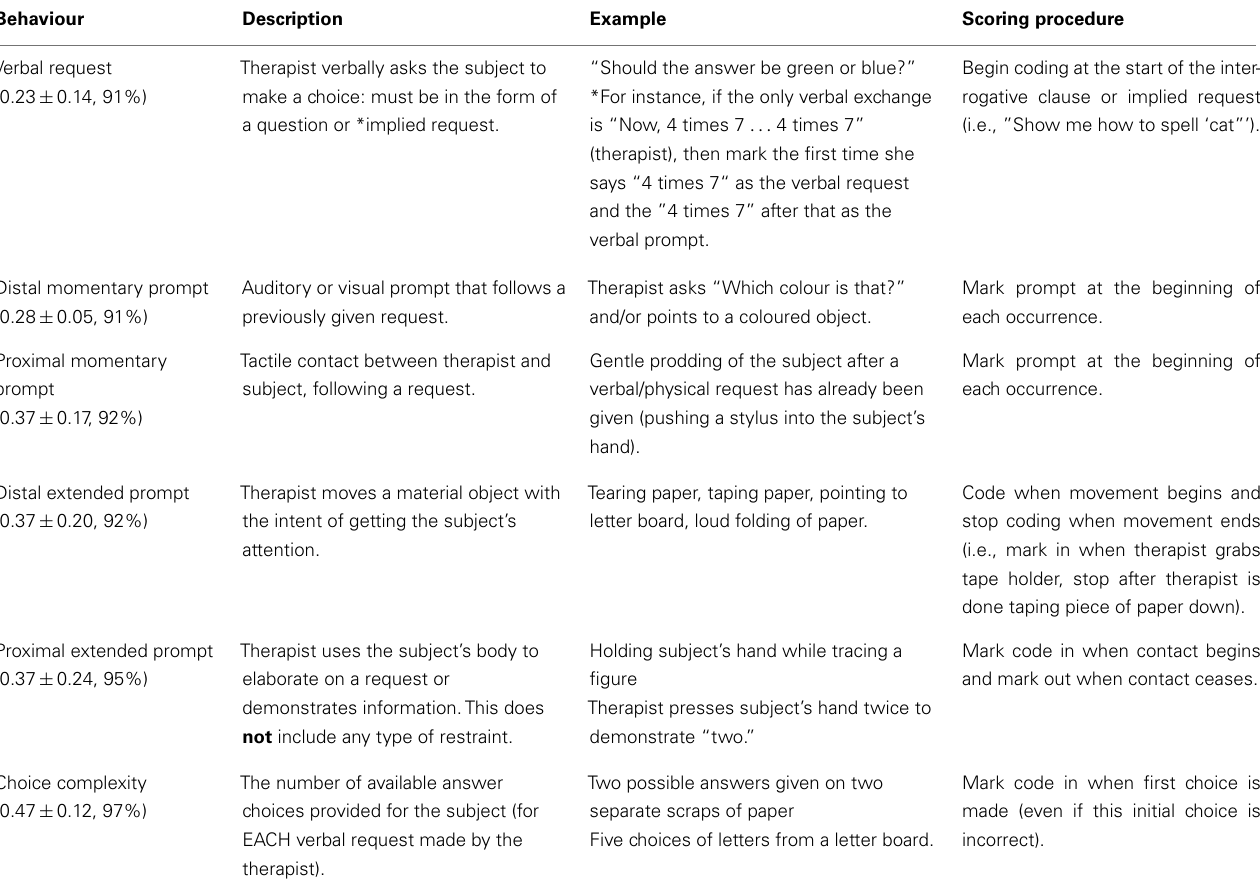
Table 4 |Therapist requests and